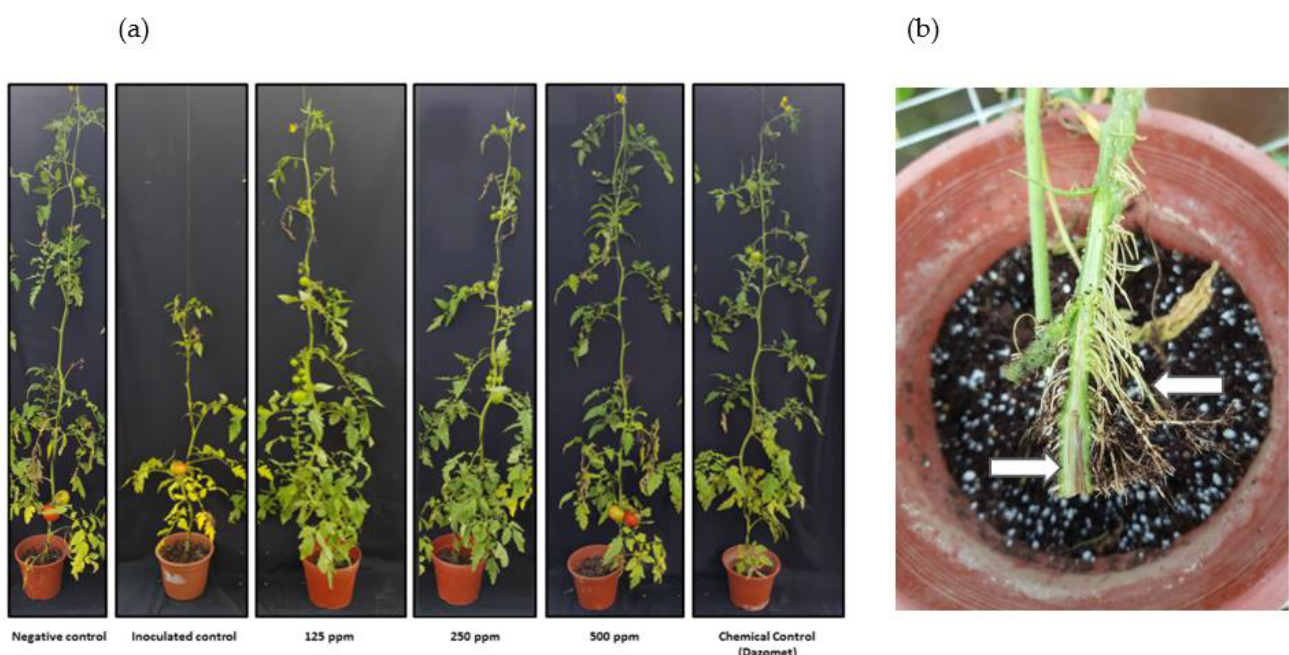
Figure 3. ( a ) Tomato plants cv. Naomi affected by Forl . The effects of three concentrations of nanoemulsion (125 ppm, 250 ppm, and 500 ppm), in comparison with two controls, one inoculated with Forl , and an uninoculated, negative control, plus a conventional chemical treatment (dazomet). ( b ) Detail of vascular browning in the xylem tissue and abundant root proliferation.